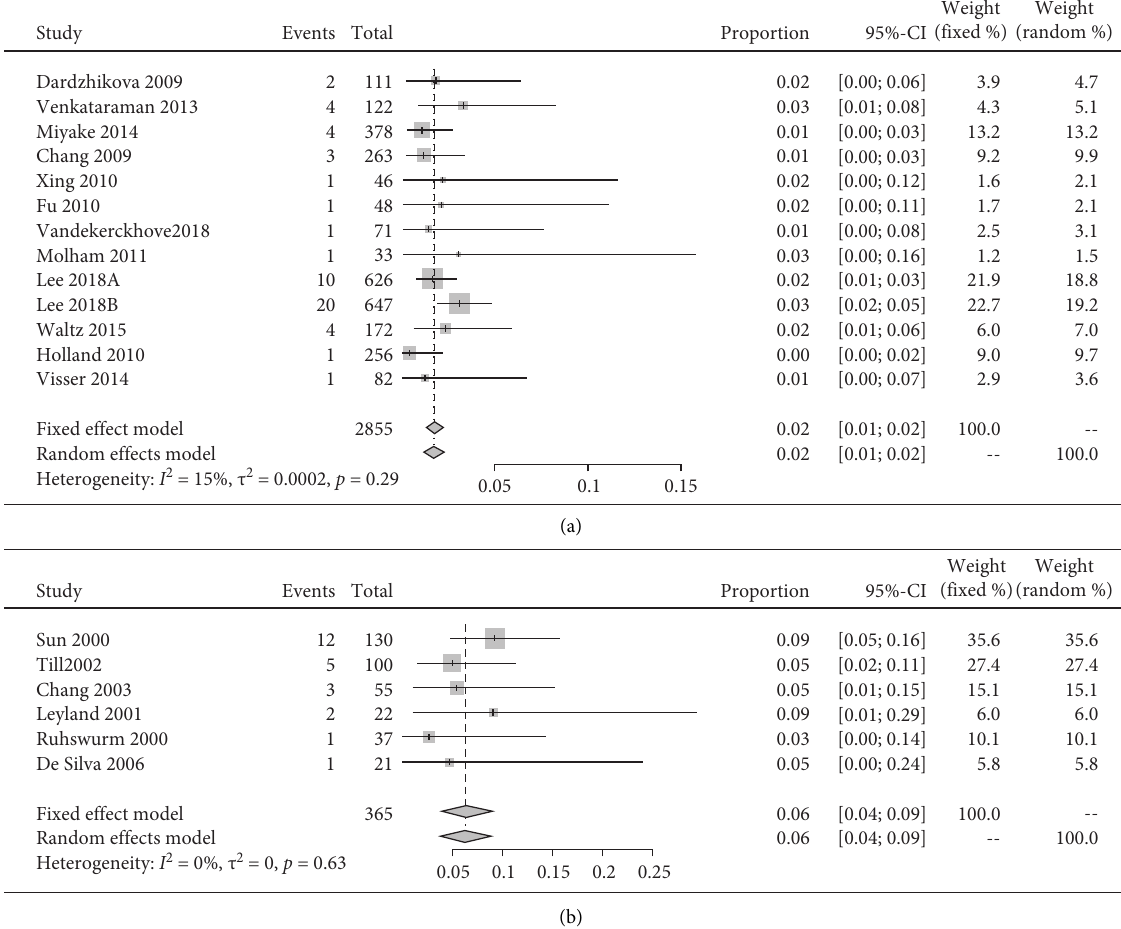
Figure 4: The forest plots displaying the pooled incidence rate of repositioning surgery of (a) hydrophobic acrylic material IOLs and (b) silicone material